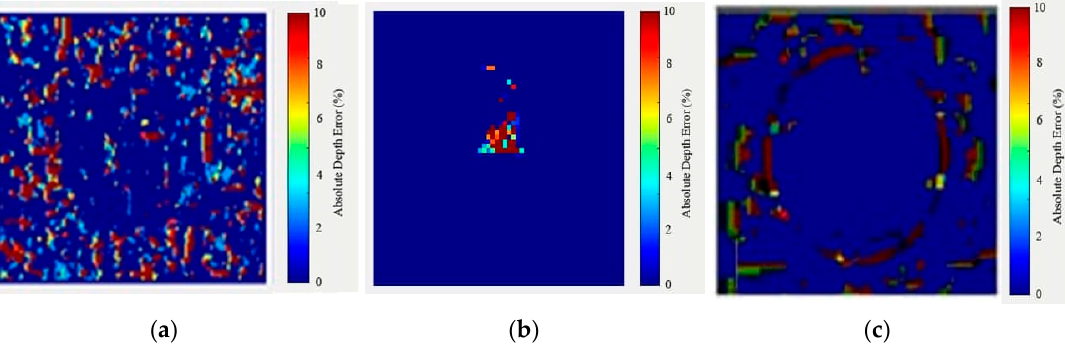
Figure 6. The error map computation result for the object ( a ) “G” ( b ) “bulb” and ( c ) “Transparent-circle”.